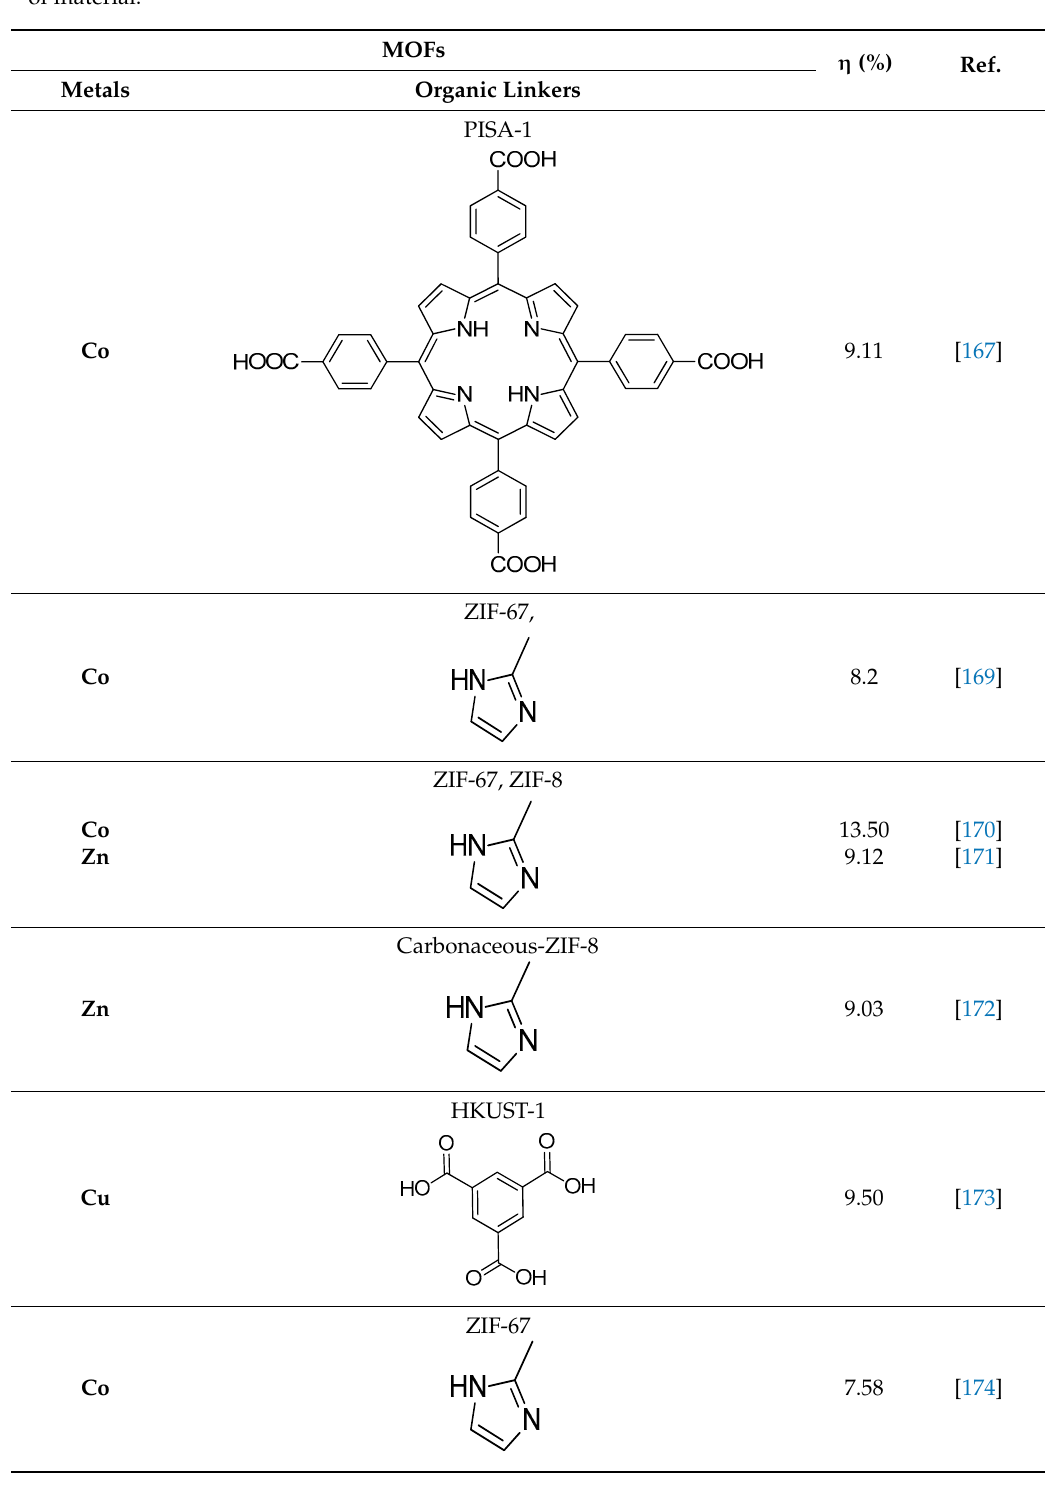
Table 3. MOFs effectively employed as counter ‐ electrodes in DSSC. For sake of brevity, we prefer to report the metal and the organic linker separately. The reported values of photoconversion efficiency could not be compared between each ‐ others, yet they could shine light on the potentiality of this class of material.